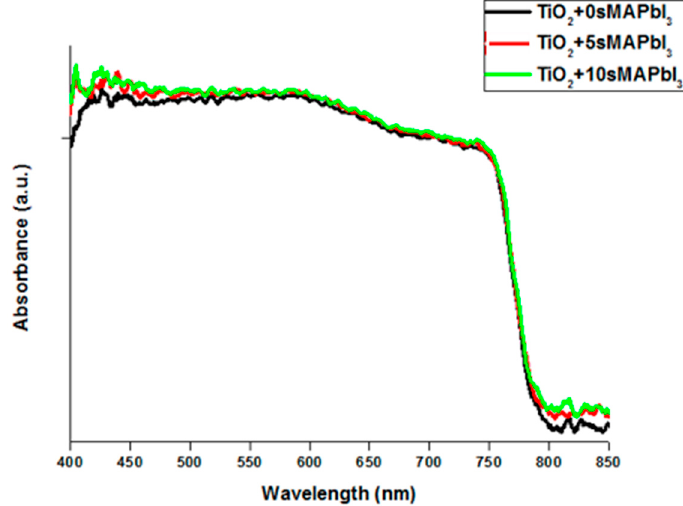
Figure 4. UV-Vis absorption spectrum of light absorbing layer film with different delay times.